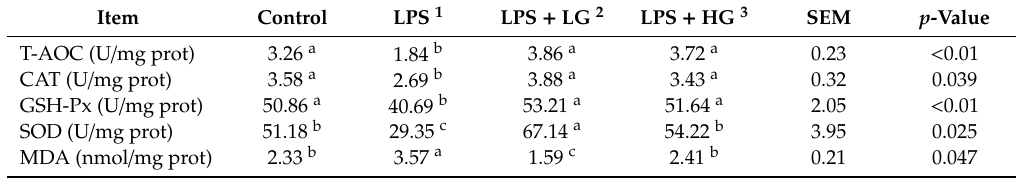
Table 6. Mucosal anti-oxidation index of piglets fed di ff erent molecular weight β